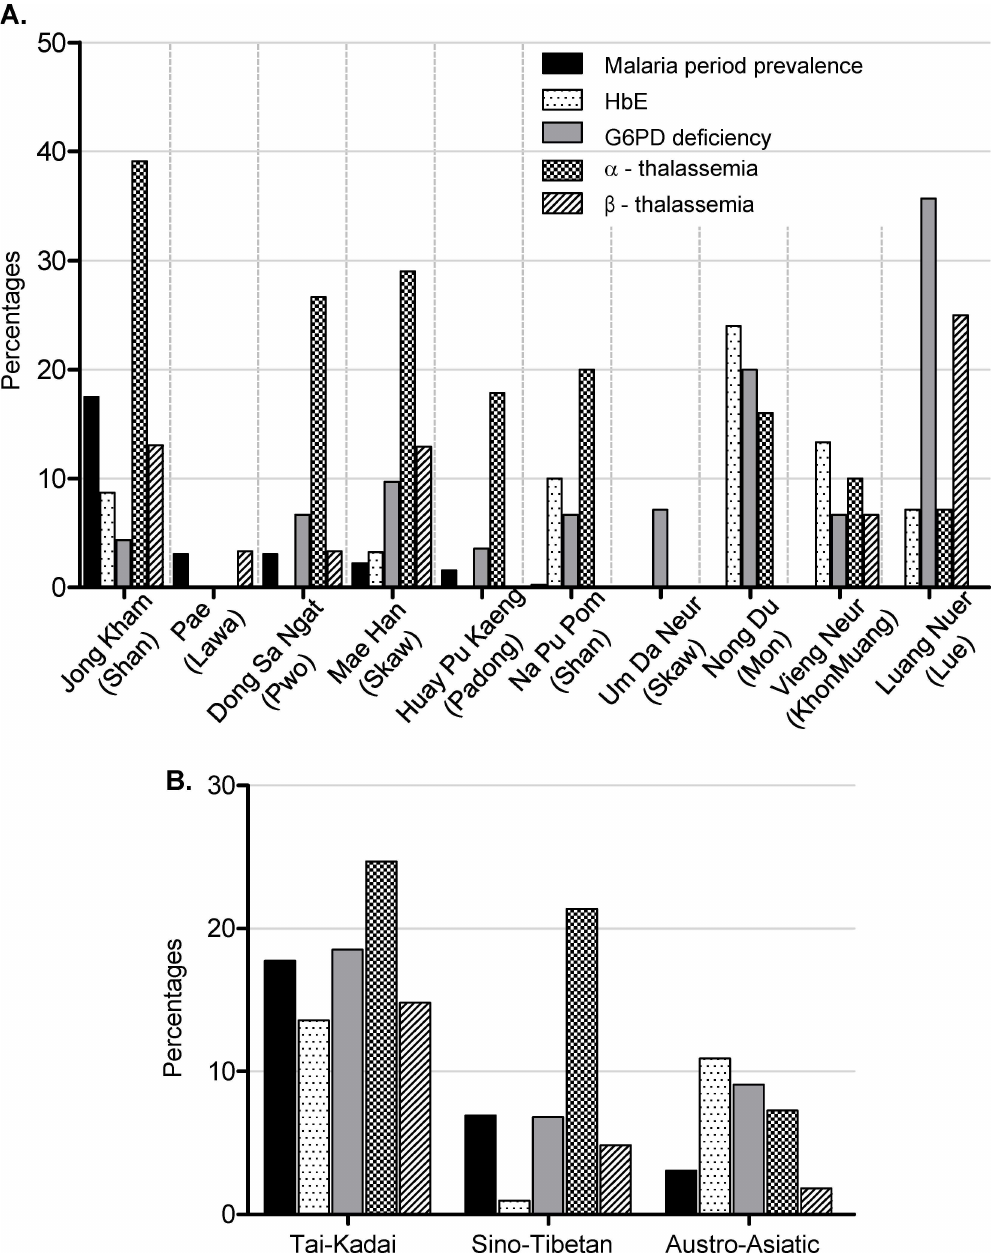
Fig 1. Proportions of studiedcharacteristics(malariaprevalence,HbE, G6PD deficiency, α -thalassemia, β -thalassemia),by villageand ethnicgroup (A) and by linguistic family